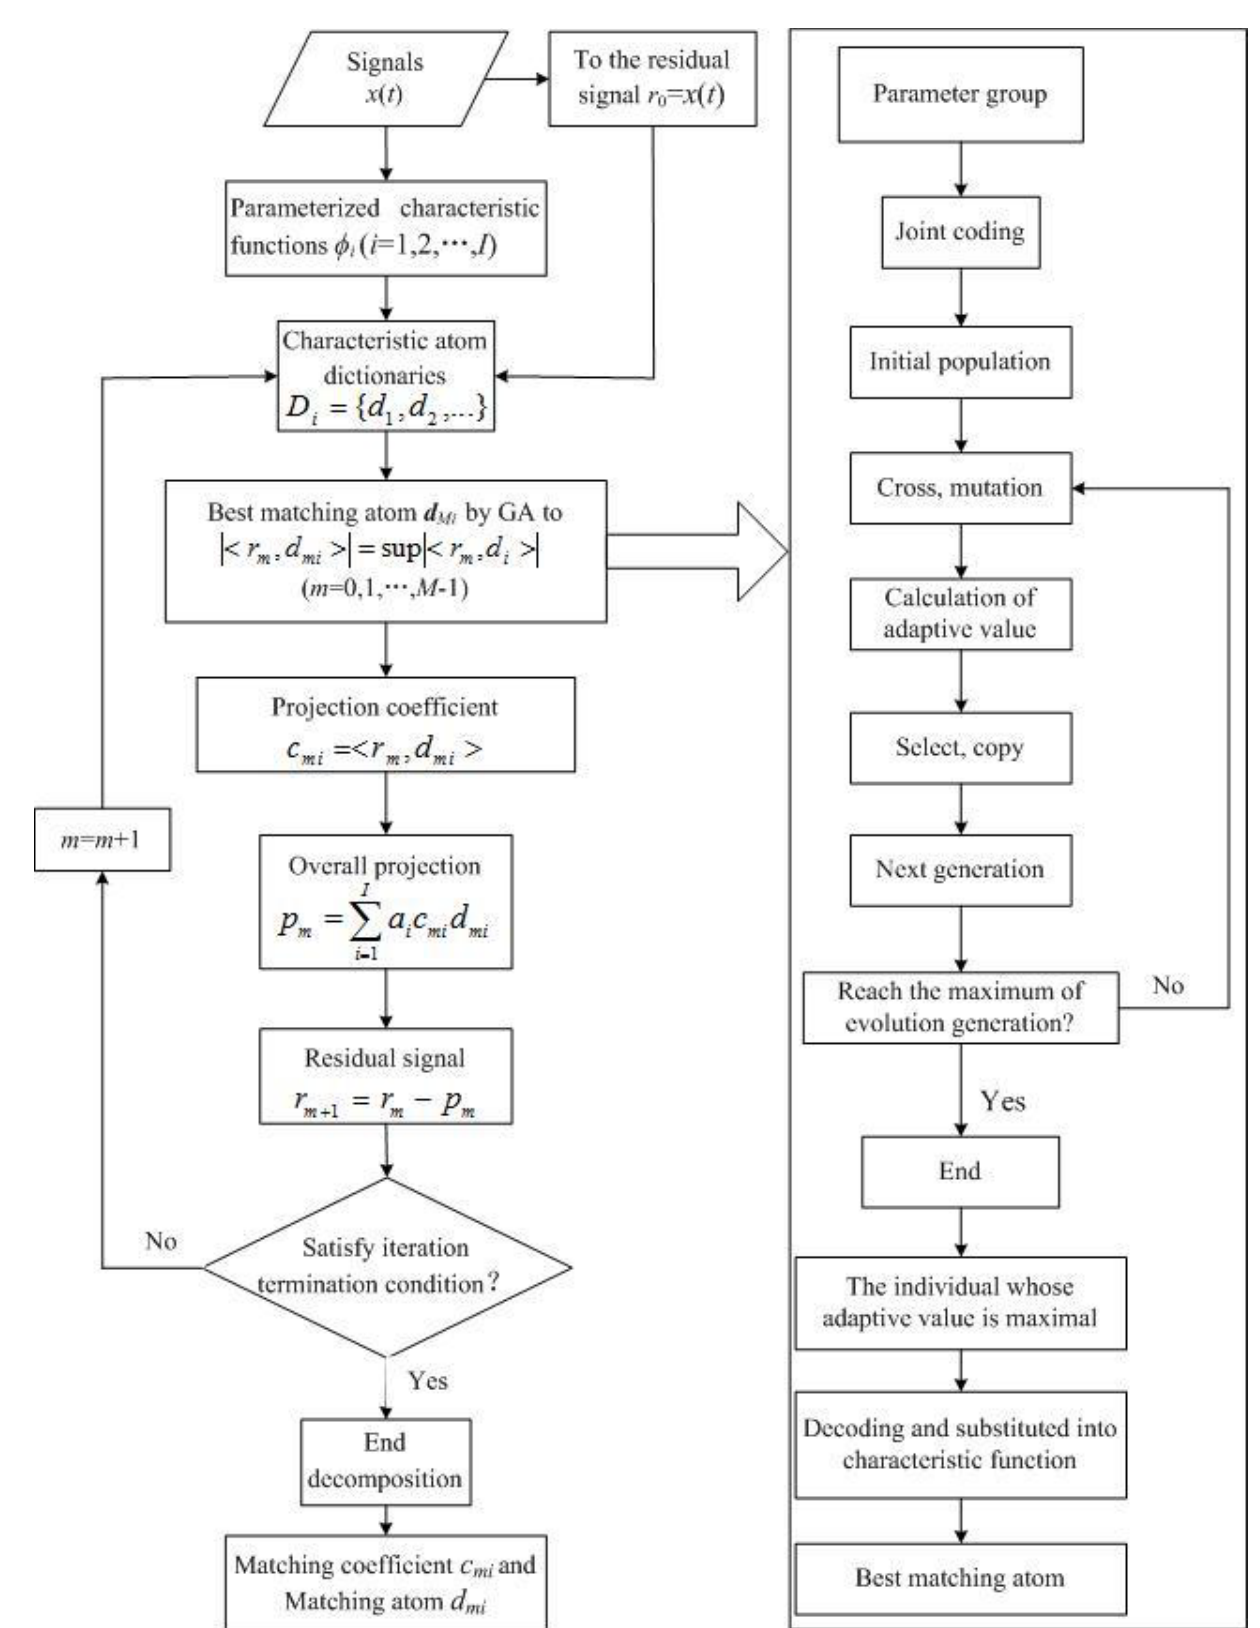
Figure 1. Flow chart of the decomposition